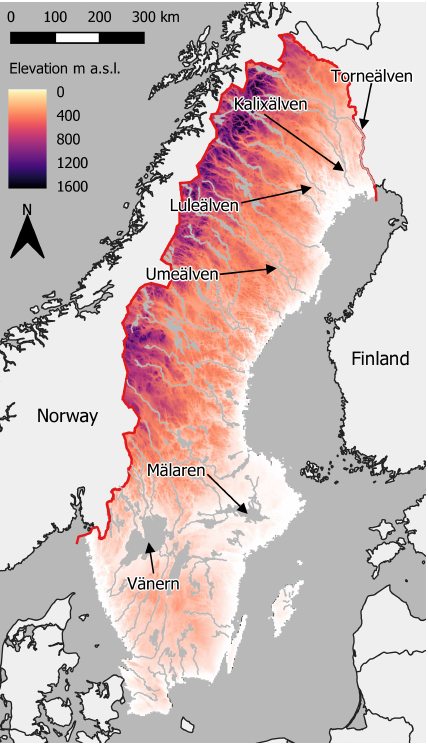
Figure A1. Map of Sweden showing its topography and main hydrographic network. The rivers and lakes referred to in the main text are indicated here for convenience.